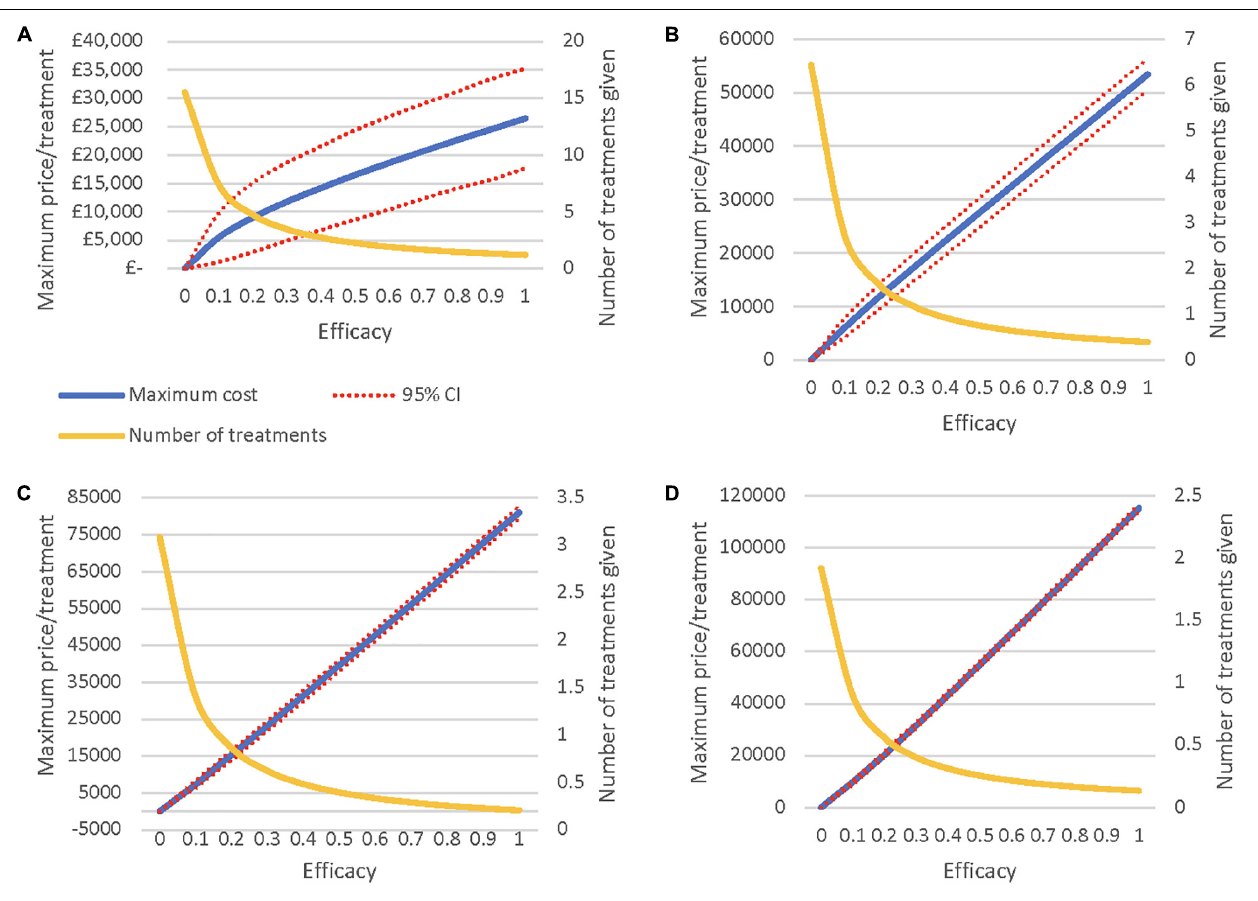
FIGURE 2 | (A) Maximum Price when treating all severities of HL. (B) Maximum Price when treating moderate HL or worse. (C) Maximum Price when treating severe HL or worse. (D) Maximum Price when treating only profound